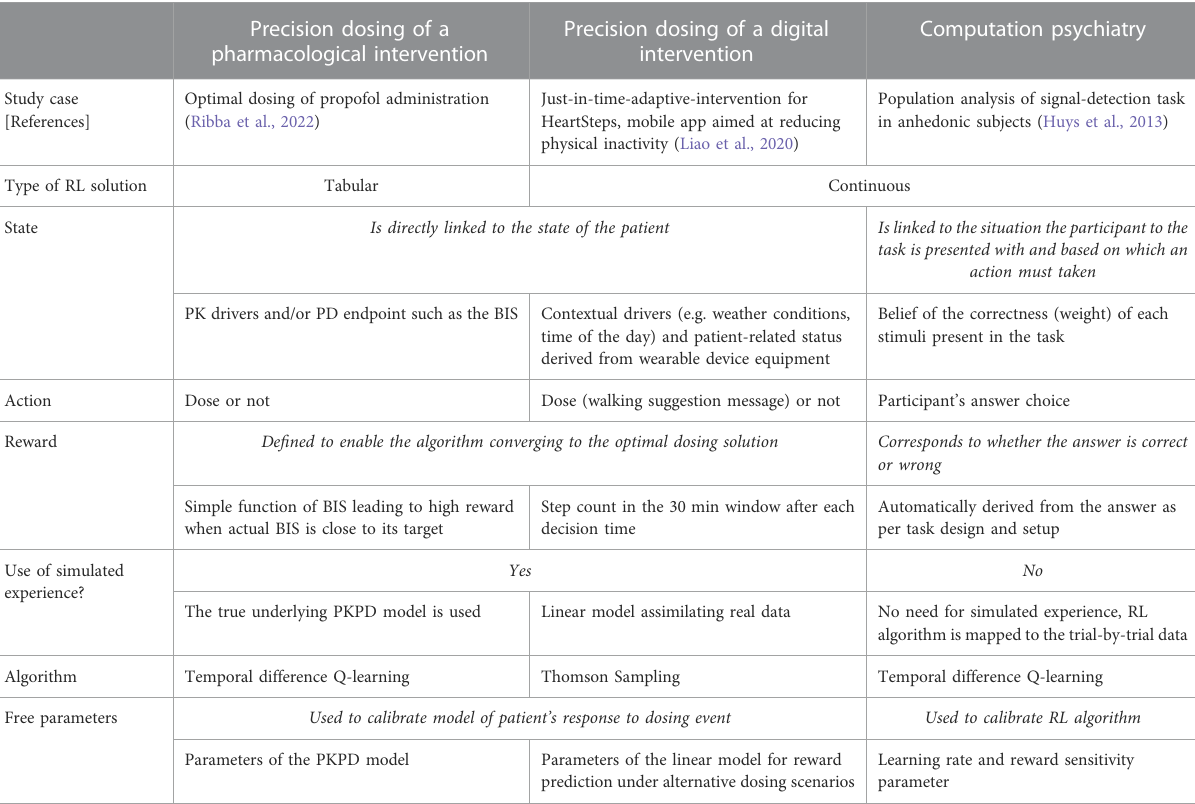
TABLE 1 Main characteristics of RL algorithm implementation to the precision dosing of pharmacological interventions (left column); the precision dosing of digital intervention (middle column); and computational psychiatry (right column). While there are multiple similarities between the precision dosing of pharmacological and digital interventions, the application of RL in computational psychiatry shows as a paradigm shift. RL computational machinery is not deployed as a technical approach to address the optimal control problem of precision dosing but is fi tted to (cognitive task) data assuming the algorithm itself presents mechanistic similarities with how brain ’ s participants functioned during the